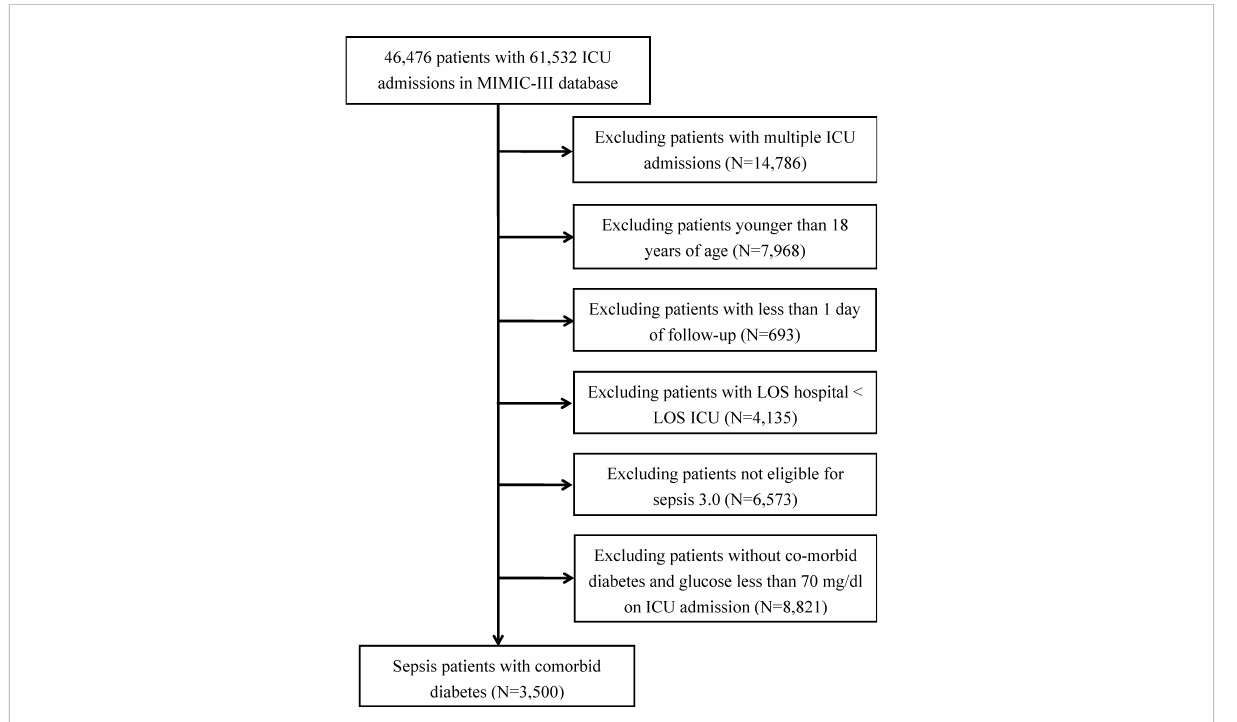
FIGURE 1 Flowchart of study participants. ICU, intensive care unit; LOS, length of